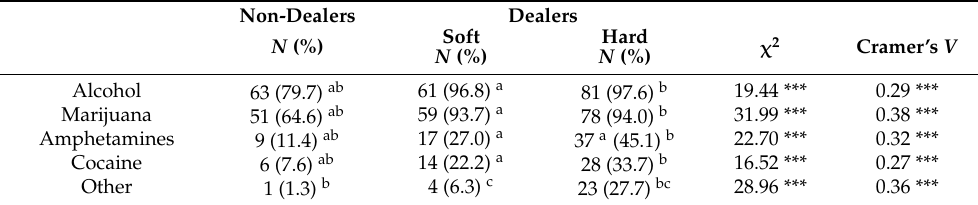
Table 7. Substance Use Among Non-Dealers ( N = 79), Soft-Drug Dealers ( N = 63) and Hard-Drug Dealers ( N =